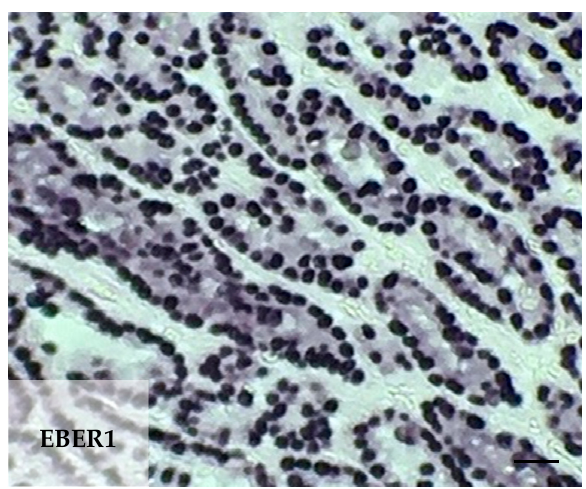
Figure 1. Epstein-Barr virus-associated gastric carcinoma. EBV-encoded small ribonucleic acid 1 (EBER1) in situ hybridization demonstrates positive nuclei in the carcinoma cells of an Alaska Native gastric cancer patient. Scale bar 25 μ m. Table 5. Demographic, clinical, and pathological characteristics of AN EBVaGC subgroup ( n = 19).